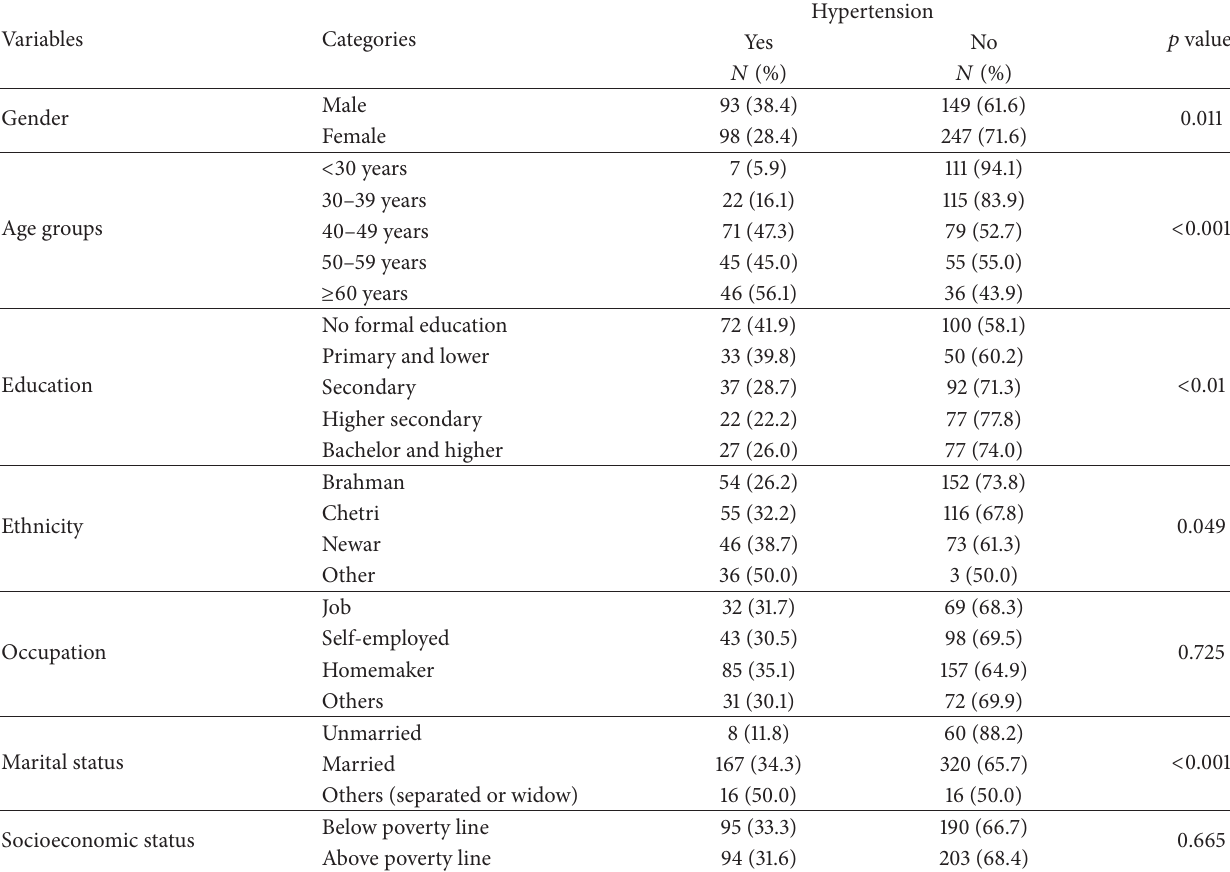
Table 2: Association of sociodemographic characteristics with